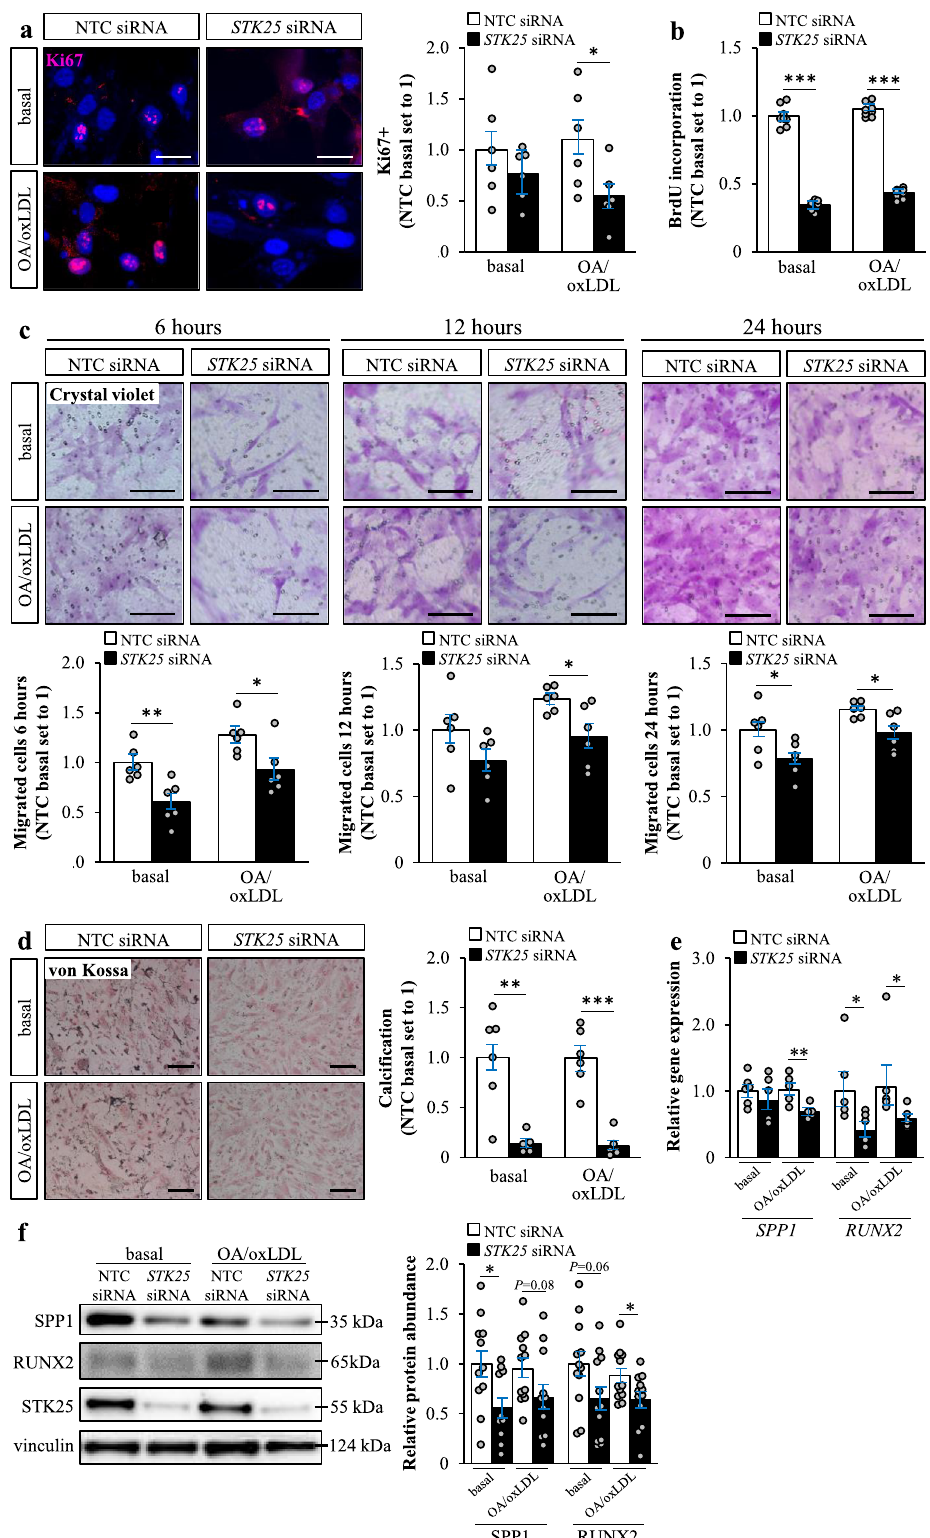
calci fi cation in smooth muscle cells transfected with STK25 vs . control siRNA. However, the exact mechanisms by which STK25 regulates transdifferentiation and phenotypic switching in smooth muscle cells still remain